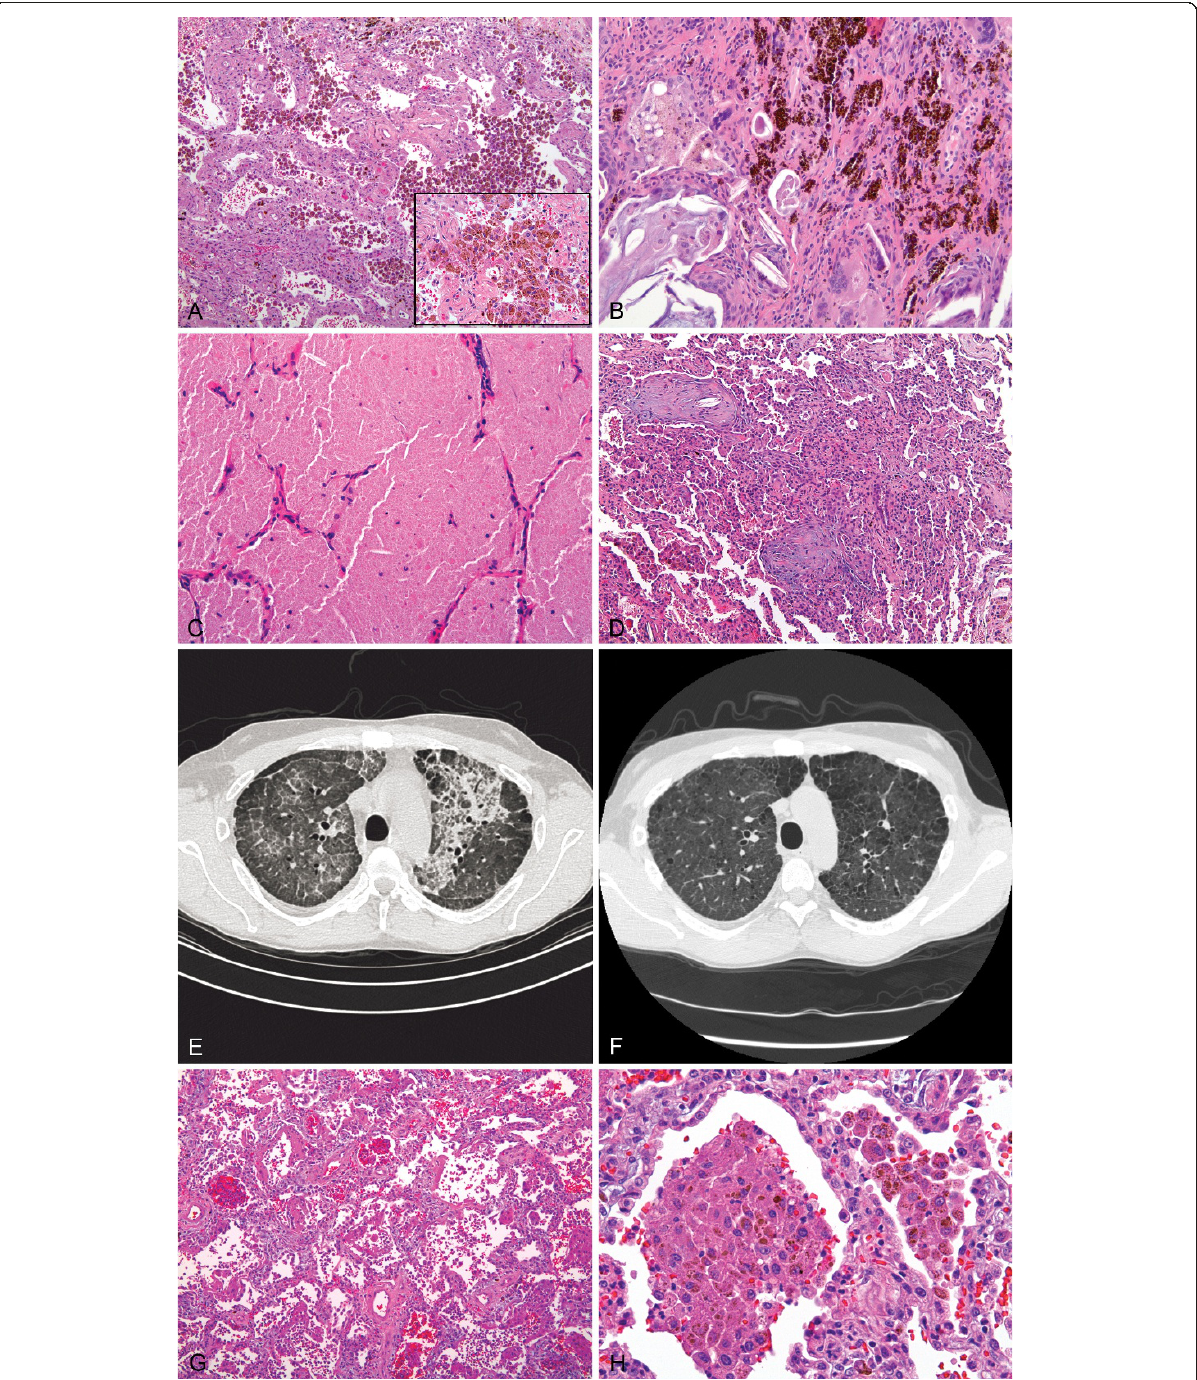
Figure 2 Pathological findings in patients with sirolimus toxicity . In case 4, open lung biopsy shows diffuse alveolar hemorrhage represented by collections of hemosiderin laden alveolar macrophages (A, inset) and occasional hemosiderin granules within interstitium, (hematoxylin-eosin, original magnification x100 and x400, respectively). In case 10, open lung biopsy shows pulmonary hemorrhage in association with pulmonary alveolar proteinosis and organizing pneumonia: there are areas with hemosiderin deposition within interstitium (B) and cholesterol granulomas, finely granular proteinaceous material with cholesterol clefting (C) and foci of organizing pneumonia (D) in adjacent alveolar parenchyma, (hematoxylin-eosin, original magnification x100, x200 and × 40, respectively). Computed tomography of the chest at the time of open lung biopsy shows diffuse ground glass and “ crazy pavement ” opacities (E). Follow up computed tomography in 8 months (F) shows marked decrease in alveolar opacities; both scans are at the level of aortic arch for comparison. In case 16, open lung biopsy shows a combination of diffuse alveolar damage and pulmonary hemorrhage: there are edematous alveolar septae lined by hyaline membranes (G) and hemosiderin-laden macrophages (H) within alveolar spaces (H&E, original magnification x200 and x400,